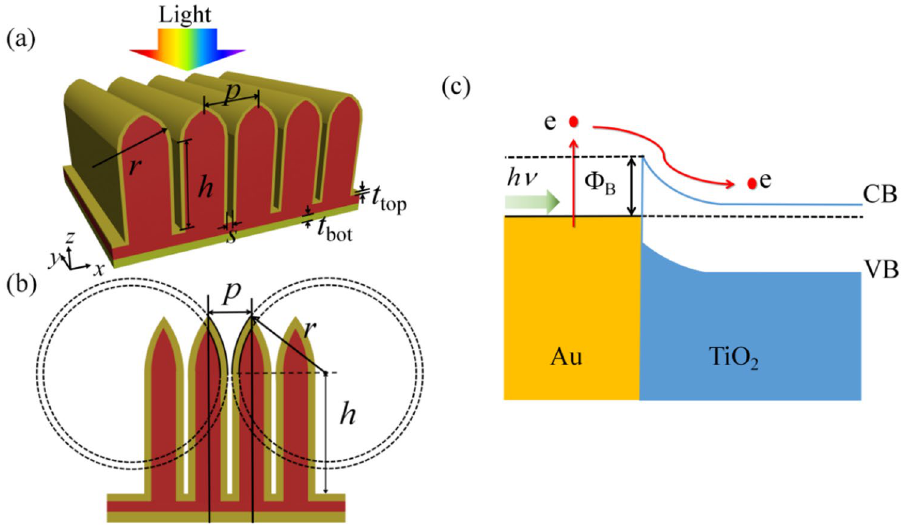
Figure 1. ( a ) Three-dimensional and ( b ) cross-sectional schematic diagrams of our proposed hot-carrier solar cell based on a special Au-TiO 2 nanowire array with each nanowire capped with a nanocone; ( c ) Band alignment at the Au-TiO 2